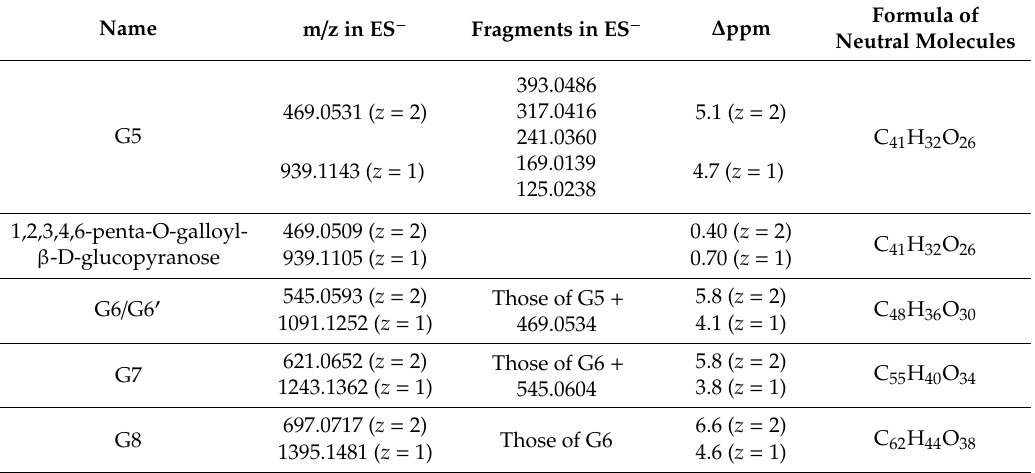
Table 1. MS and MS–MS data of G5-G8 and 1,2,3,4,6-penta-O-galloyl- β